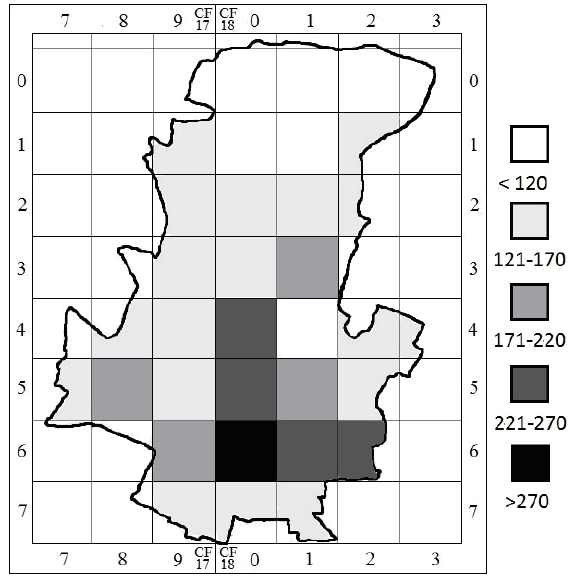
Fig. 2. A spatial variation in number of species within grid cells In the vascular plant flora of Strzelce